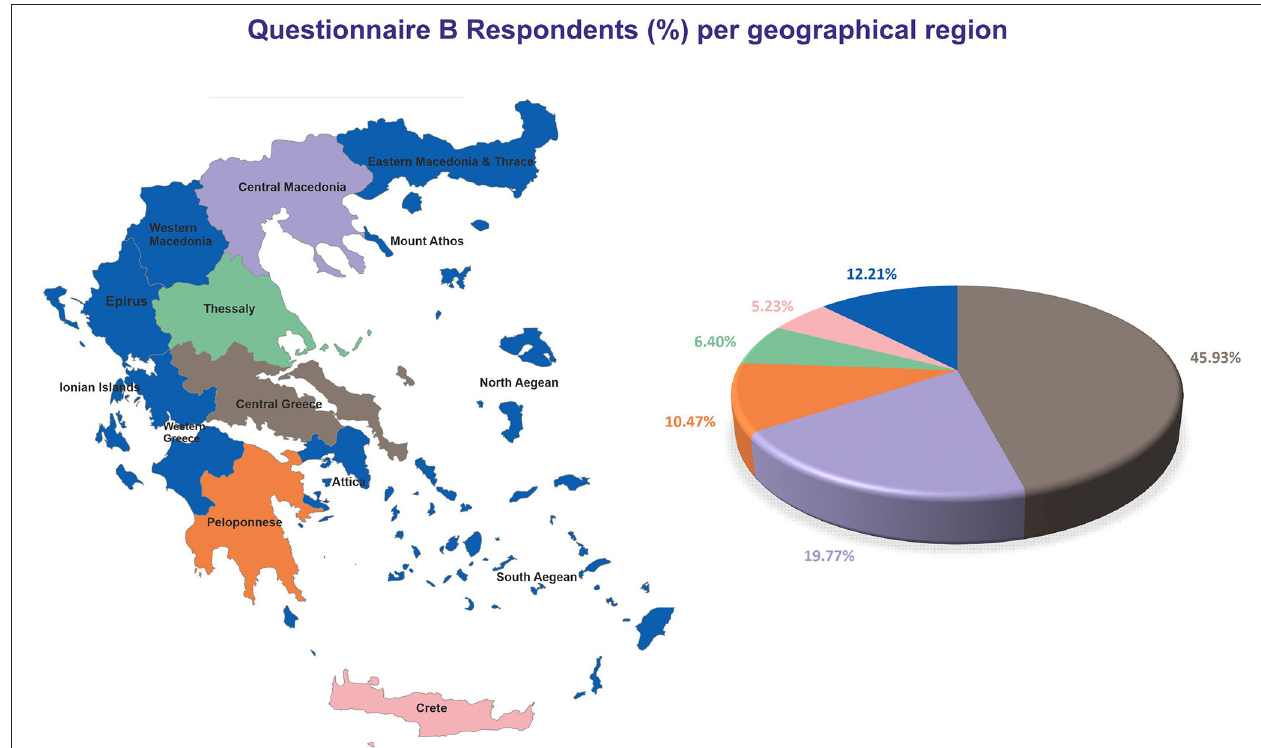
FIGURE 4 | Geographical distribution of respondents for Questionnaire